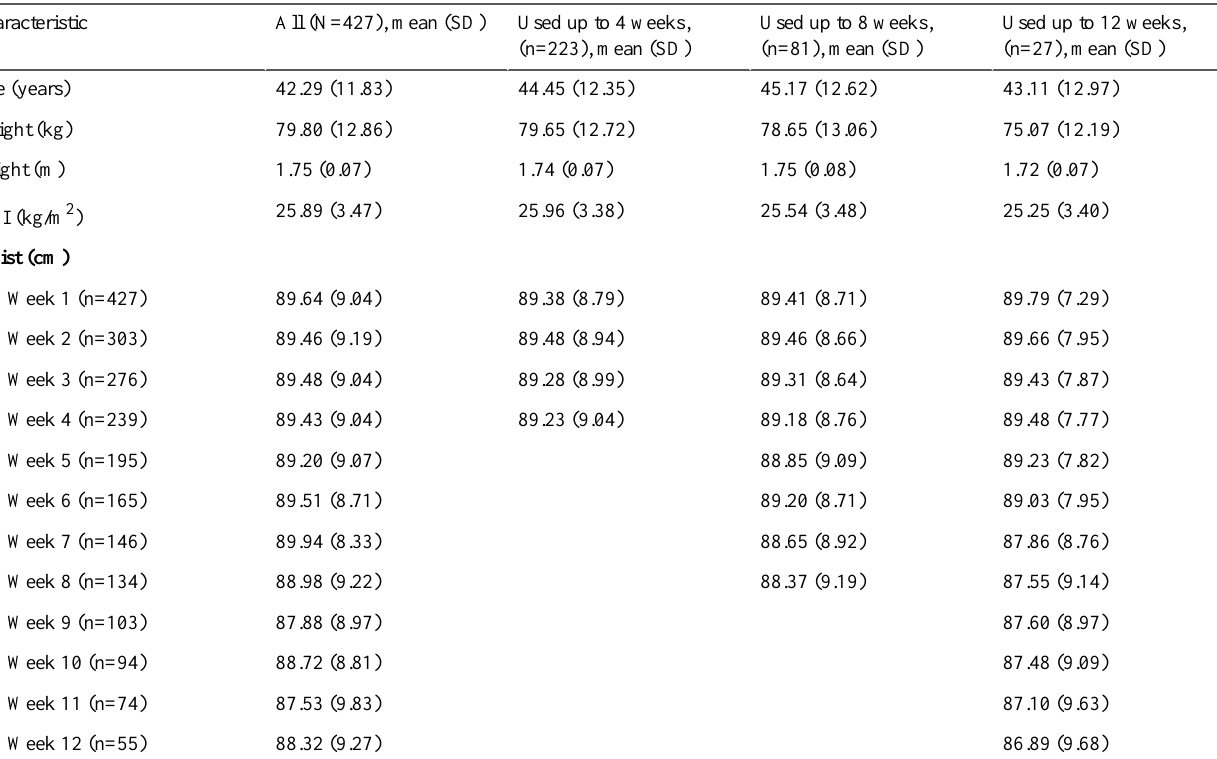
Table 1. Descriptive statistics of smart belt users. Except for waist circumference, other characteristics, including age, weight, height, and body mass index (BMI), were self-reported at baseline when the user first started using the app.